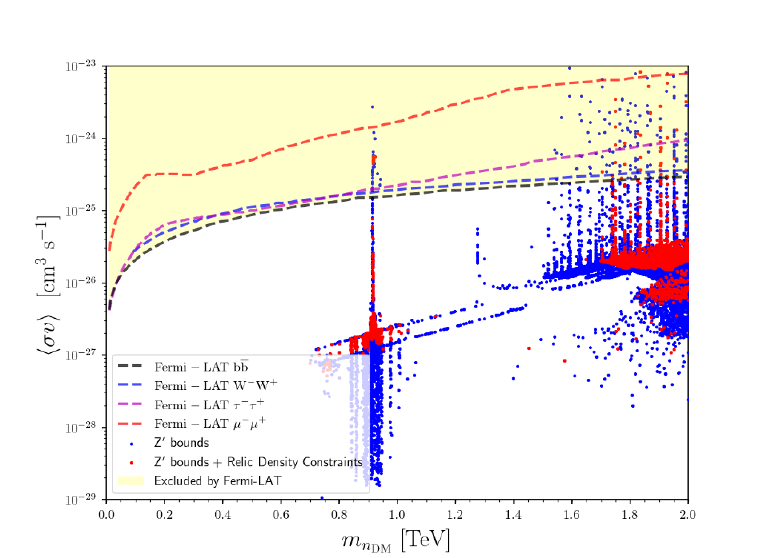
Figure 3 . Predictions for the total DM annihilation cross section as a function of the mass of the lightest scotino. We show all points returned by the scan and that are compatible with LHC Z 0 bounds. Scenarios for which the predictions for the relic density agree with Planck data are shown in red, whilst scenarios for which DM is over-abundant or under-abundant are shown in blue. We superimpose to our predictions constraints from Fermi-LAT [65], the yellow area being